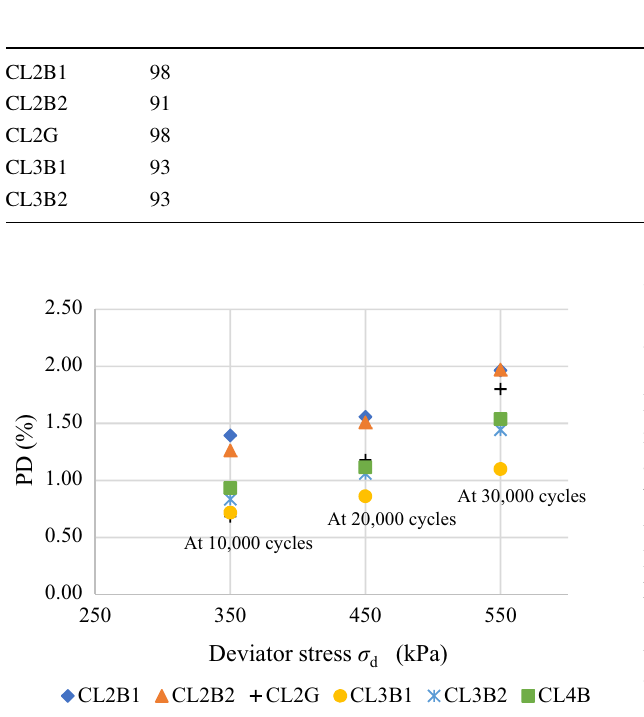
Table 6 Influence of compaction level on PD of the tested materials Material